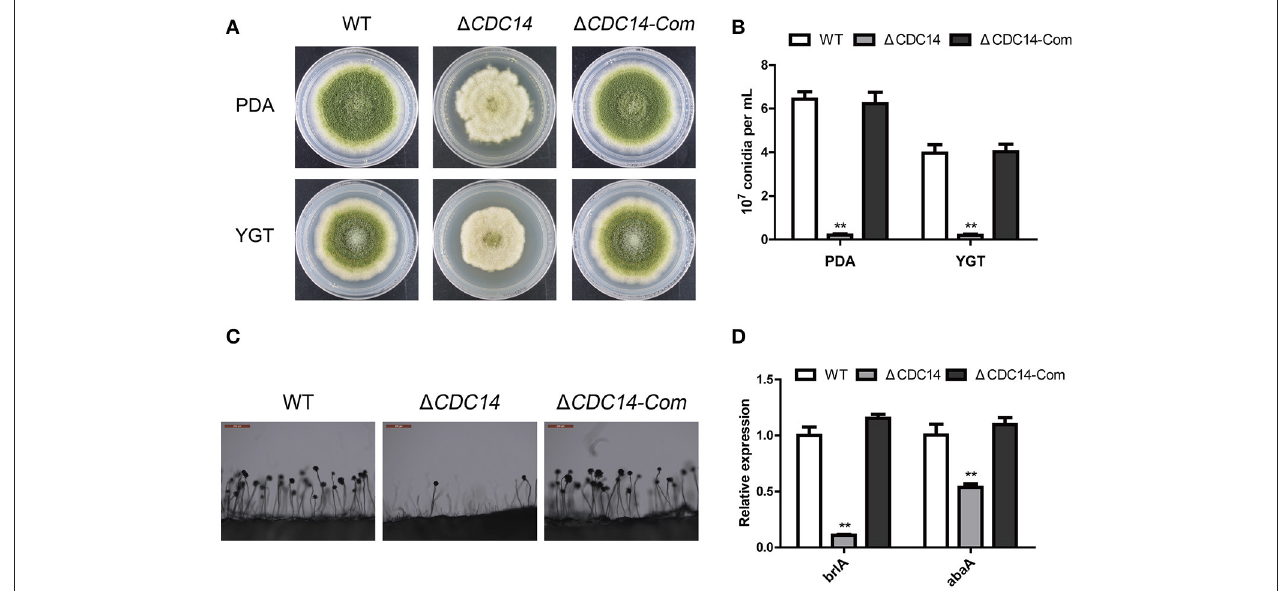
FIGURE 4 | Deletion of AflCDC14 caused defects of conidiation in A. flavus . (A) Colonies of WT, 1 CDC14 and 1 CDC14- Com strains cultured on PDA and YGT media at 37 ◦ C for 5 d. (B) Conidia amount produced by the different strains on PDA and YGT media. (C) Conidiophores morphology of WT and CDC14 mutants observed by